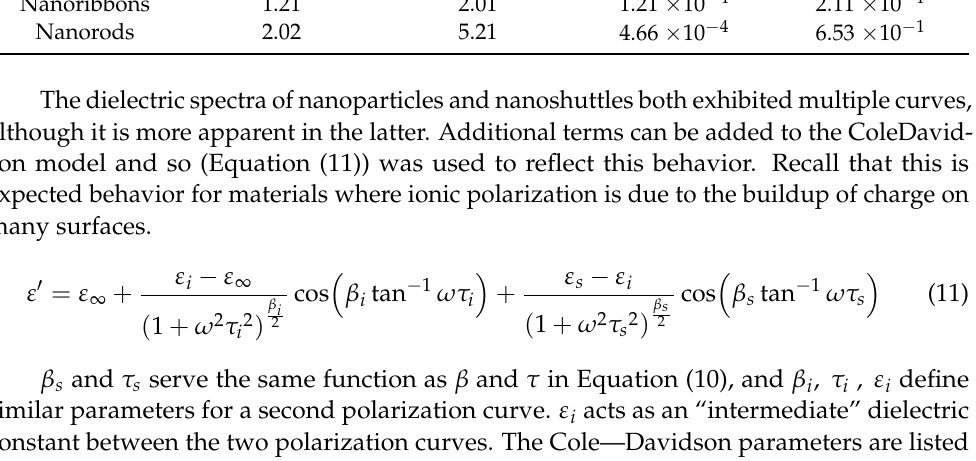
Table 3. Cole-Davidson parameters for nanoribbons and, nanorods. Morphology